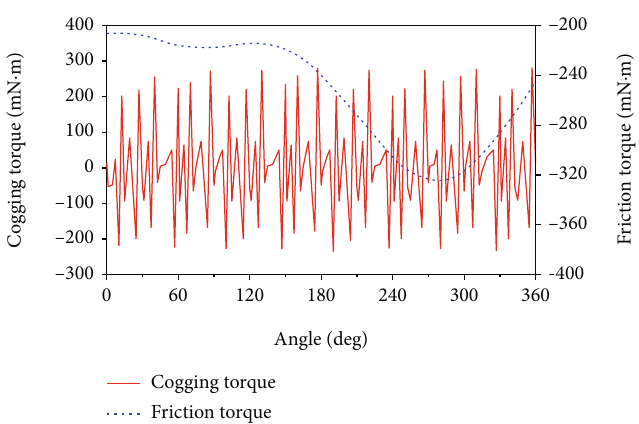
Figure 14: The cogging torque experimental curve.